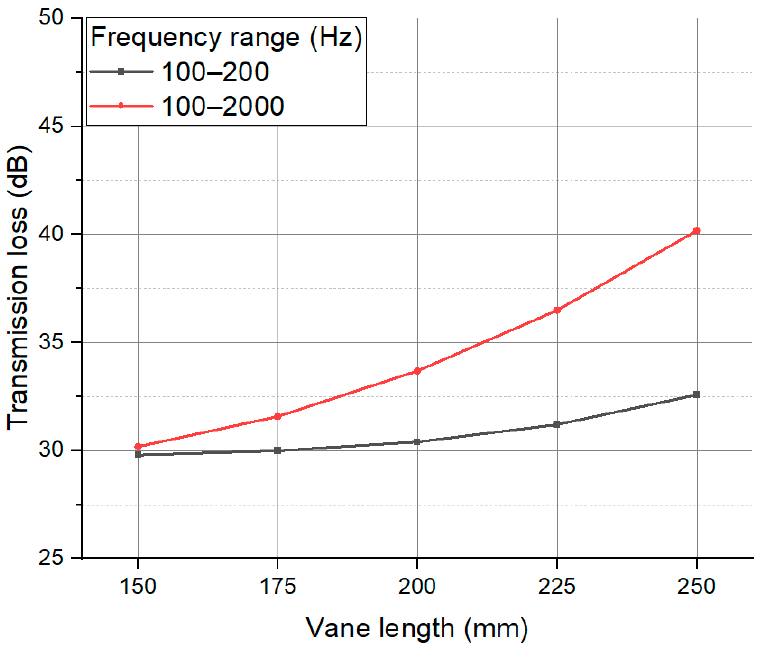
Figure 12. Transmission loss according to the vane length in the inner vane reverse type.